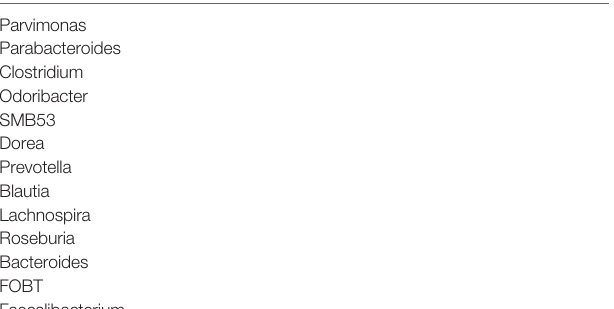
TABLE 1 | The weight for CRC and healthy gut classi fi cation of 12 bacteria genus and